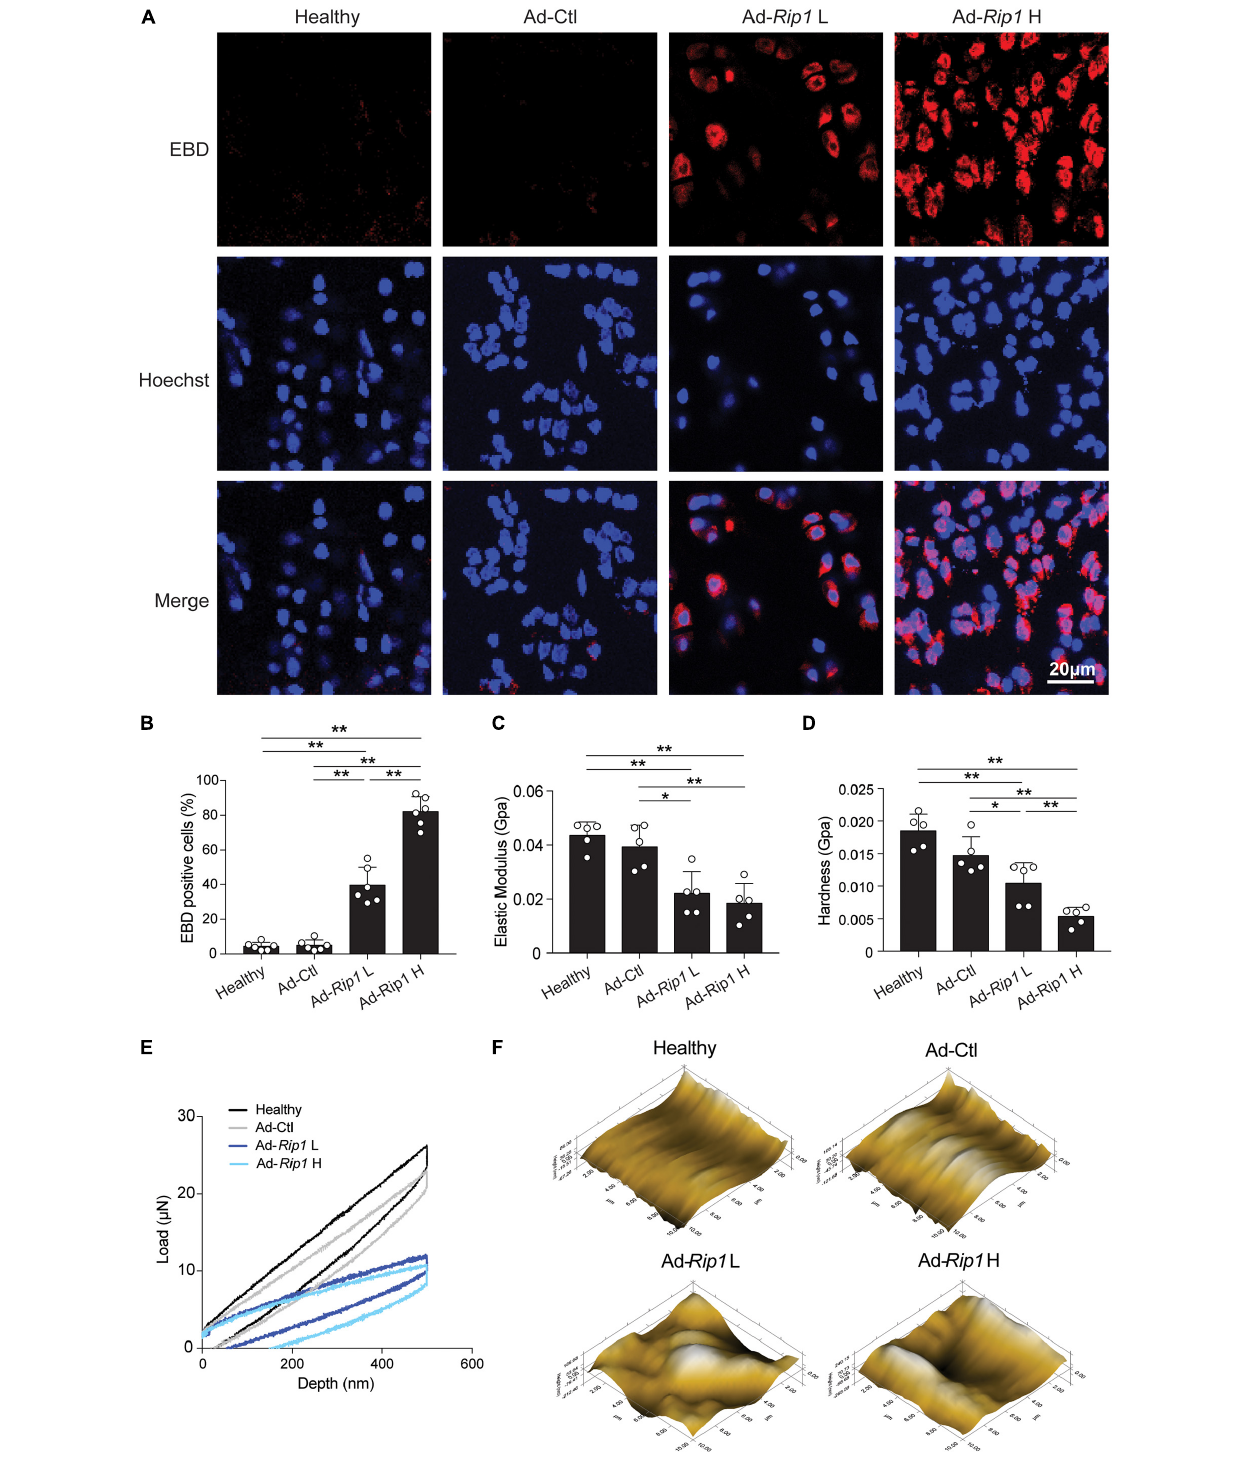
FIGURE 4 | Intra-articular injection of Ad- Rip1 causes chondrocyte necroptosis and impaired biomechanical properties of rat cartilage. (A,B) Representative photomicrographs (A) and quantitative data (B) of chondral EBD uptake (red) in cartilage from rats intra-articularly injected with Ad-Ctl (5 × 10 8 pfu) and two different doses of Ad- Rip1 (10 8 pfu, 5 × 10 8 pfu) ( n = 6 for each group). Cell nuclei were labeled by Hoechst. (C–F) Elastic modulus (C) , hardness (D) , load-displacement curves (E) , and microscopic geomorphology (F) of cartilage surface from rats intra-articularly injected with Ad-Ctl (5 × 10 8 pfu) and two different doses of Ad- Rip1 (10 8 pfu, 5 × 10 8 pfu) evaluated by nanoindentation test ( n = 5 for each group). * P < 0.05 and ** P < 0.01.